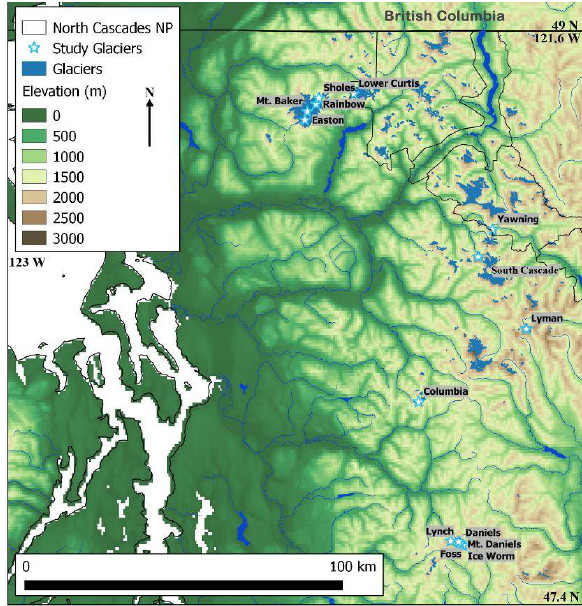
Figure 1. Base map of the North Cascades, indicating glaciers observed in detail by the North Cascade Glacier Climate Project (NCGCP).